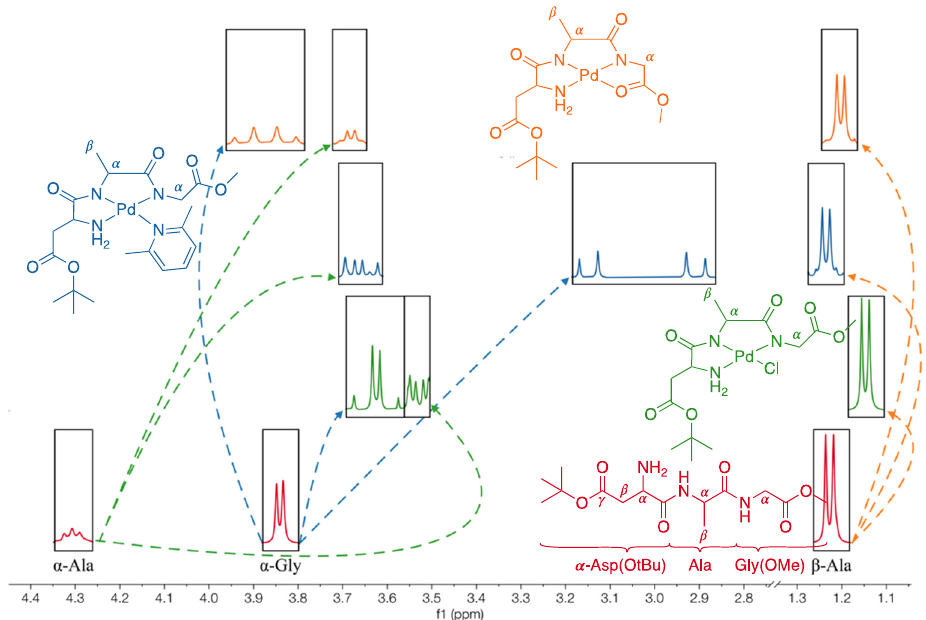
Figure 5. Progression of select 1 H-NMR resonances of 1 (red) to 4 (green), 8 (blue), and 9 (orange). In 11 , the appearance of the NH 2 protons at 4.96 and 4.24 ppm confirmed the N-ter- minus amine coordination, whereas the indole resonances were relatively unchanged, suggesting the N-indole amine remained uncoordinated. Ala ( Δδ 0.56 ppm) and Trp ( Δδ 0.11 ppm) α -C protons shifted downfield and were in agreement with 9 and 10 . The 13 C NMR spectrum collected for the ligands 1 – 3 (Table S2) and complexes 4, 8– 11 (Table 3) were tabulated and compared. Assignments for the carbon spectrum were aided by the 2D-NMR technique HSQC. As expected, all α -carbons shifted downfield, while Ala α -carbons underwent the largest downfield shifts and had the broadest range. Table 3. Assigned 13 C-NMR resonances for complexes 4 , 8 – 11 .